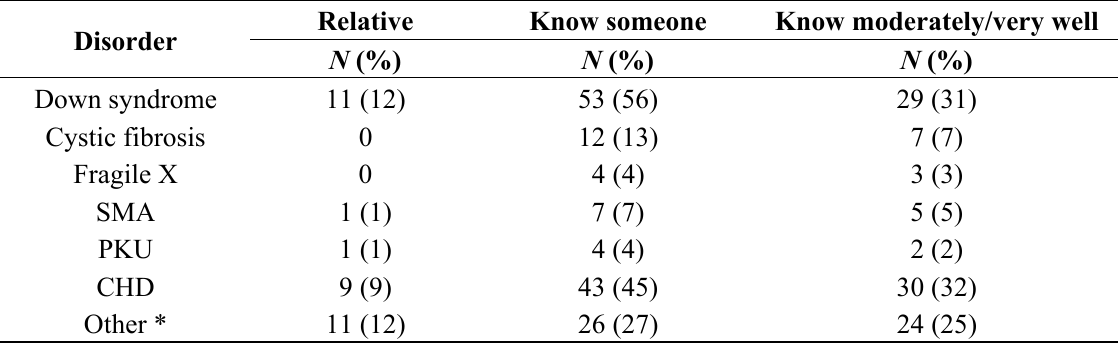
Table 3. The number of subjects who are related to or know someone with congenital